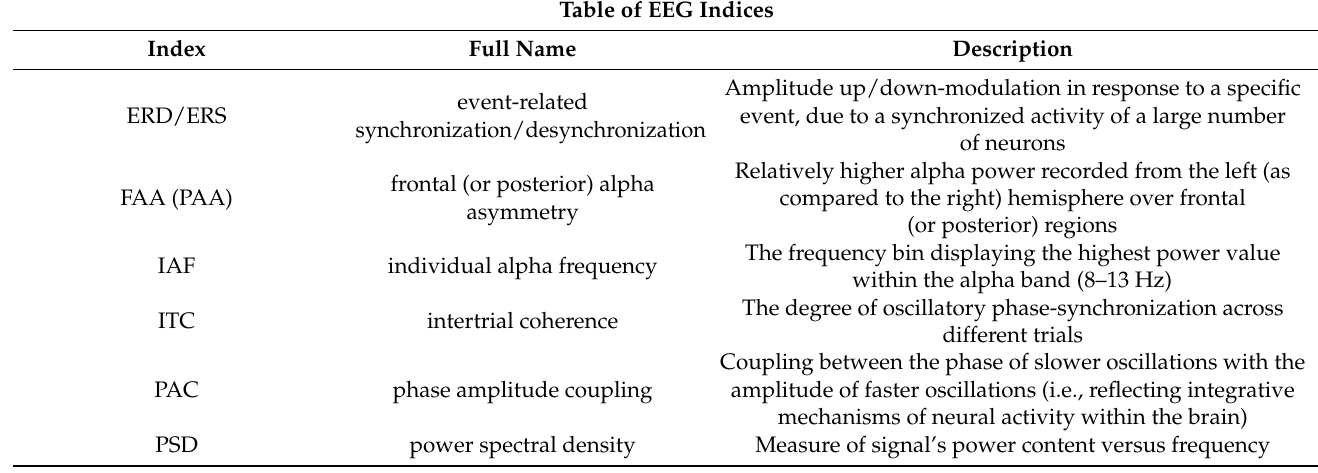
Table 1. Table showing the main electrophysiological indices used for the review, along with a brief